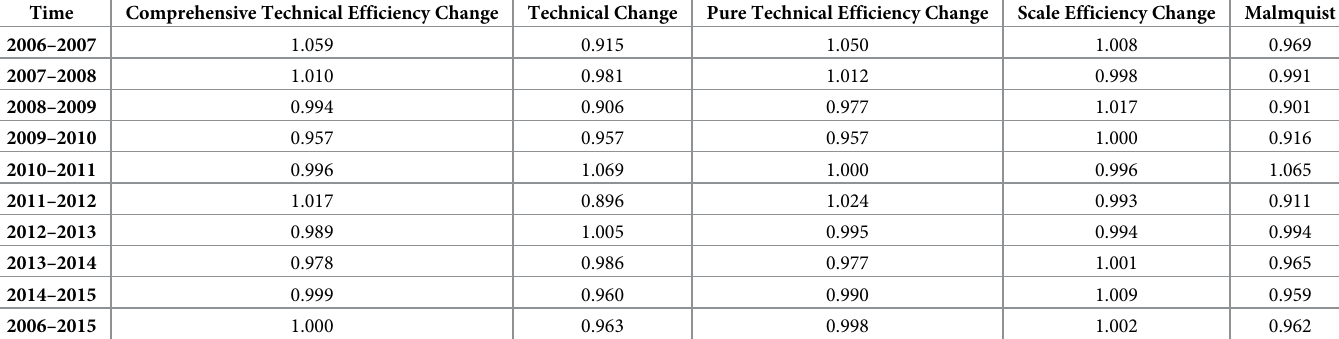
Table 7. Temporal dynamic evolution in agricultural carbon emission efficiency of the provinces along B&R, 2006–2015. Time Comprehensive Technical Efficiency